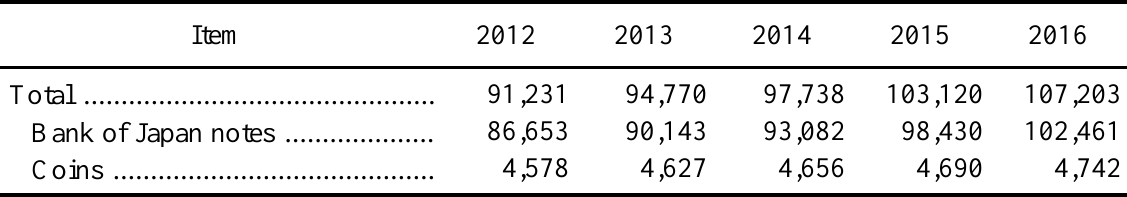
Currency in Circulation (Outstanding at year-end)